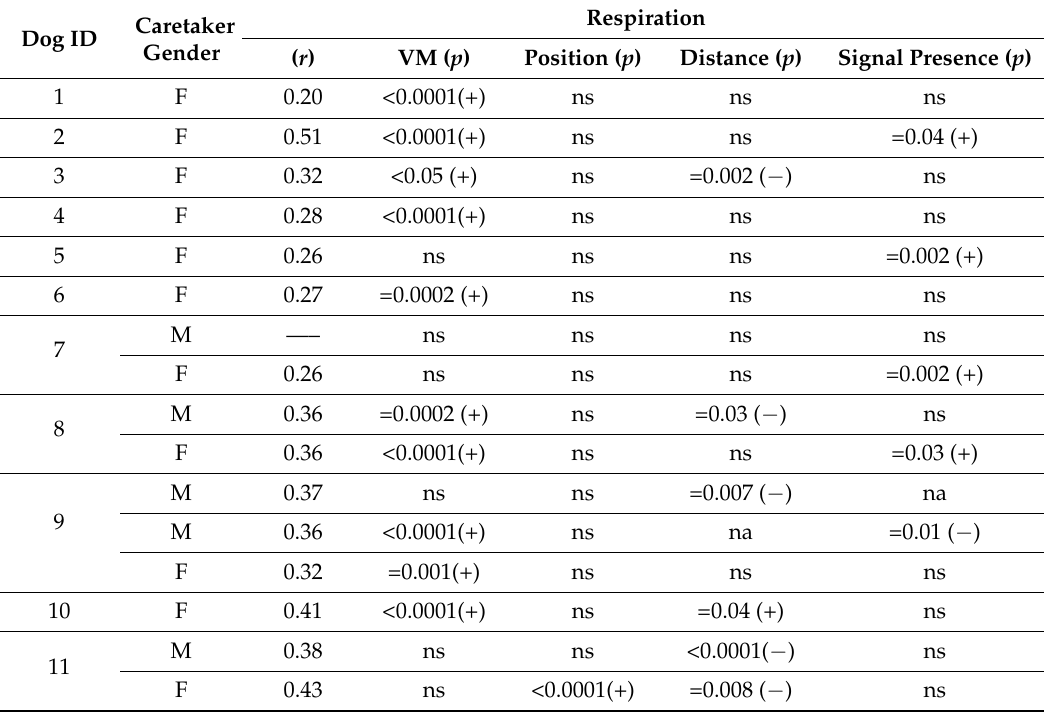
Table 5. Predictors of respiration during sedentary bouts.